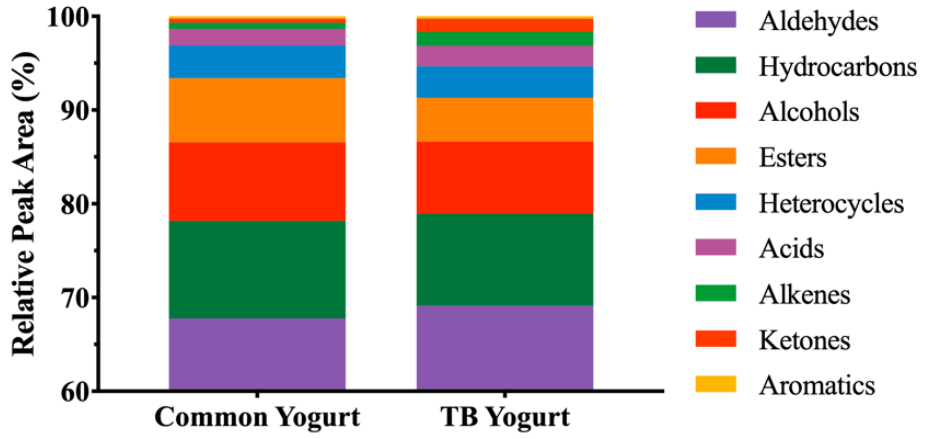
Figure 5. Comparison of volatile compounds in common yogurt and TB yogurt.